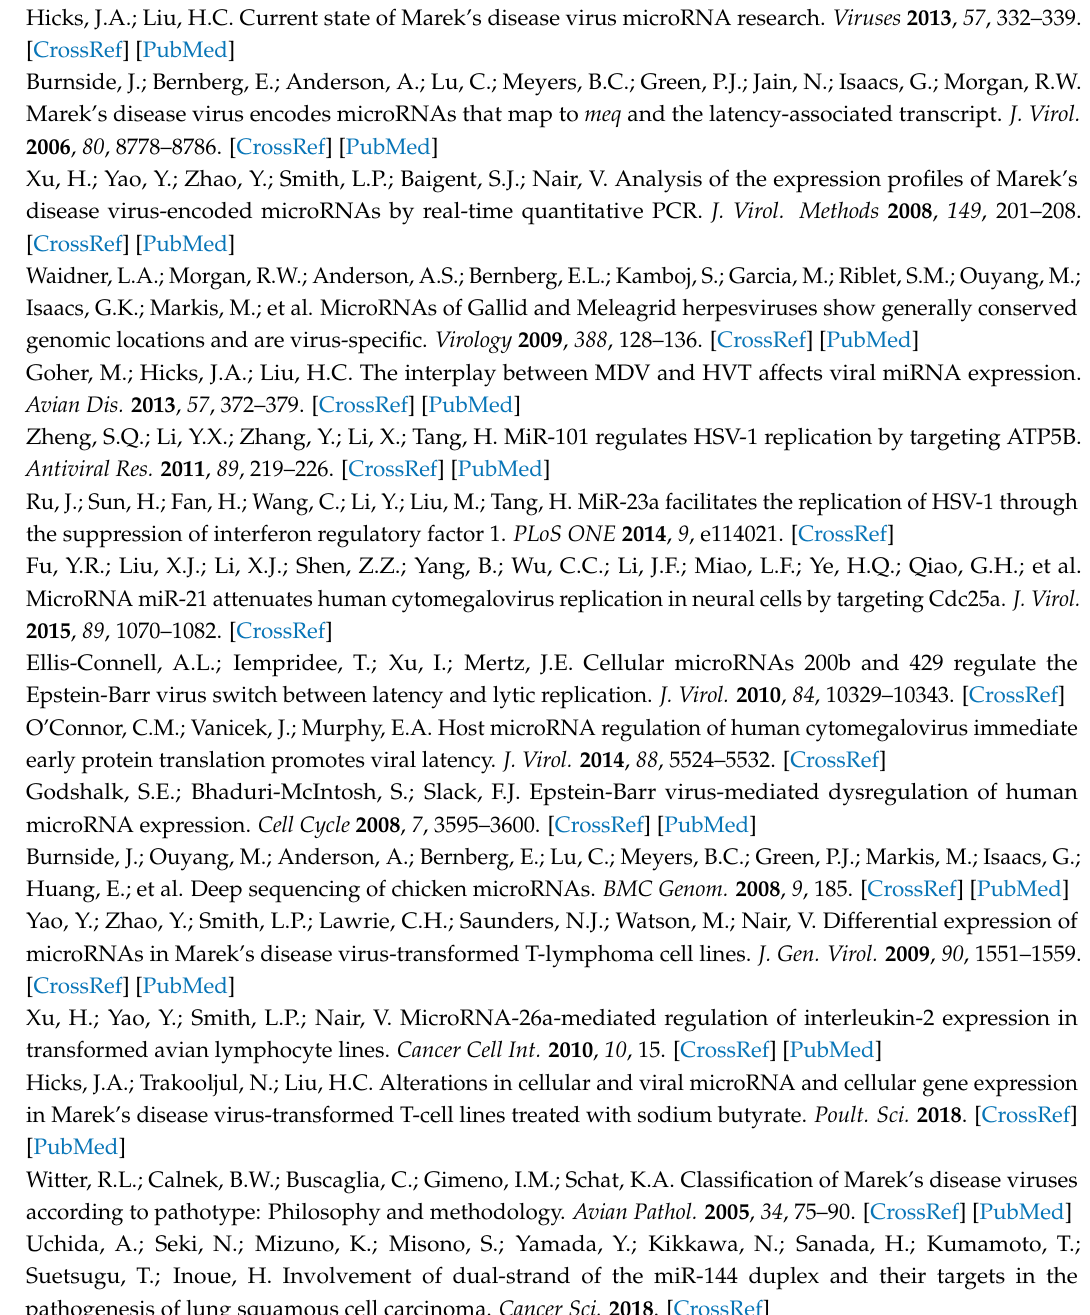
s1 Table S1: Primers used in this study, Figure S1: Splenic expression of MDV MEQ and HVT HVT071